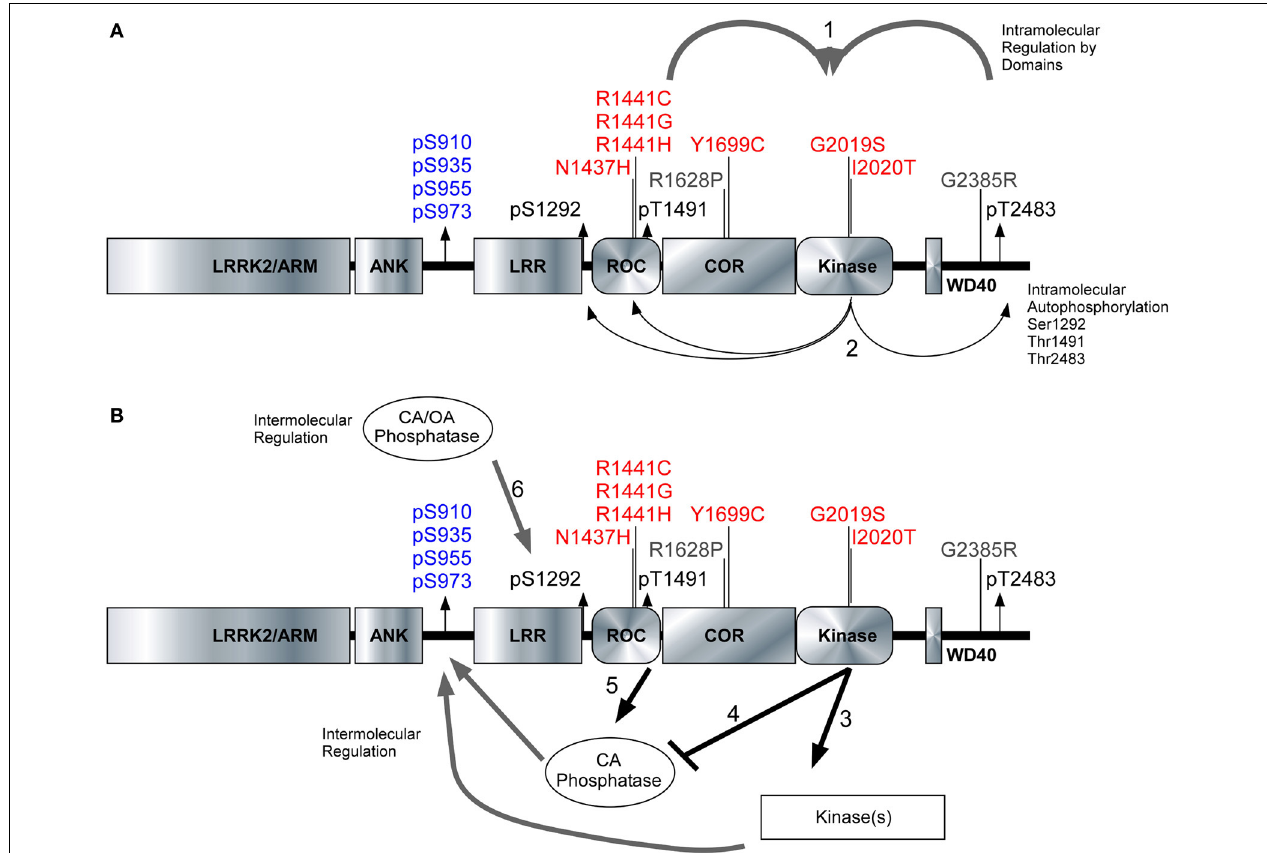
FIGURE 6 | Model of intramolecular and intermolecular LRRK2 regulation. The LRRK2 structure with PD associated mutants highlighted in red (pathogenic) and risk factors in gray. Cellular phosphorylation sites are highlighted in blue and autophosphorylation sites are in black. (A1) The intramolecular regulation of the PD associated mutants in the Roc-COR domain and the carboxy terminus on LRRK2 kinase activity. (A2) Differential effects of the PD mutations can be detected through the autophosphorylation sites Ser1292, Thr1491, and Ser2483. (B3,B4)